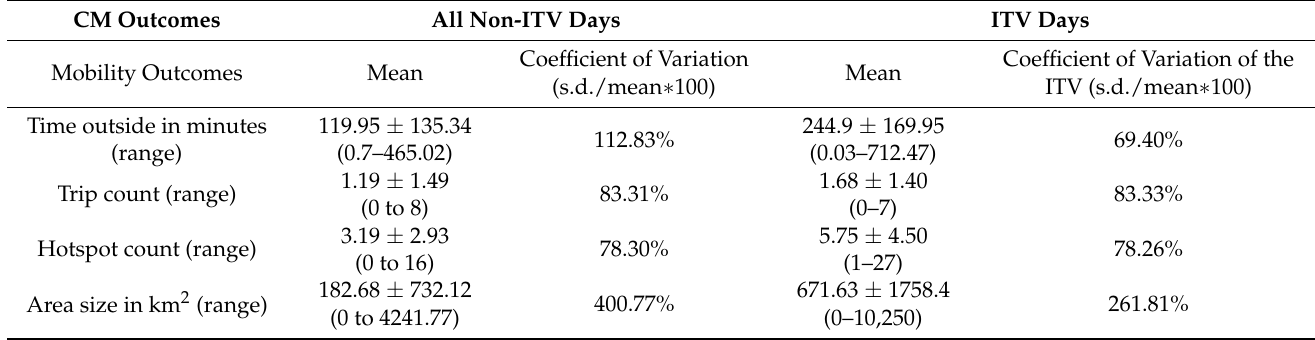
Table 2. Average community mobility outcomes recorded using different sampling lengths (n = 14). Days with 800 or more minutes of recording constitute ITV days, and those with less are non-ITV days. Coefficient of variation for ITV days used the mean and s.d. of all ITV days in the formula: s.d./mean ∗ 100. Non-ITV mean values were calculated using the average for all non-ITV subgroups, and this mean was used to calculate the non-ITV coefficient of variation. (ITV = individual true